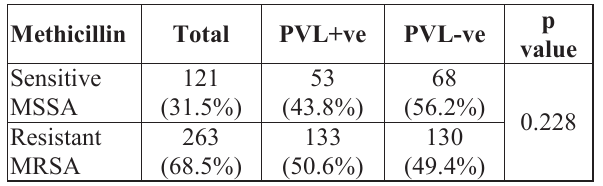
Table-6: Relationship between Methicillin sensitivity and PVL gene